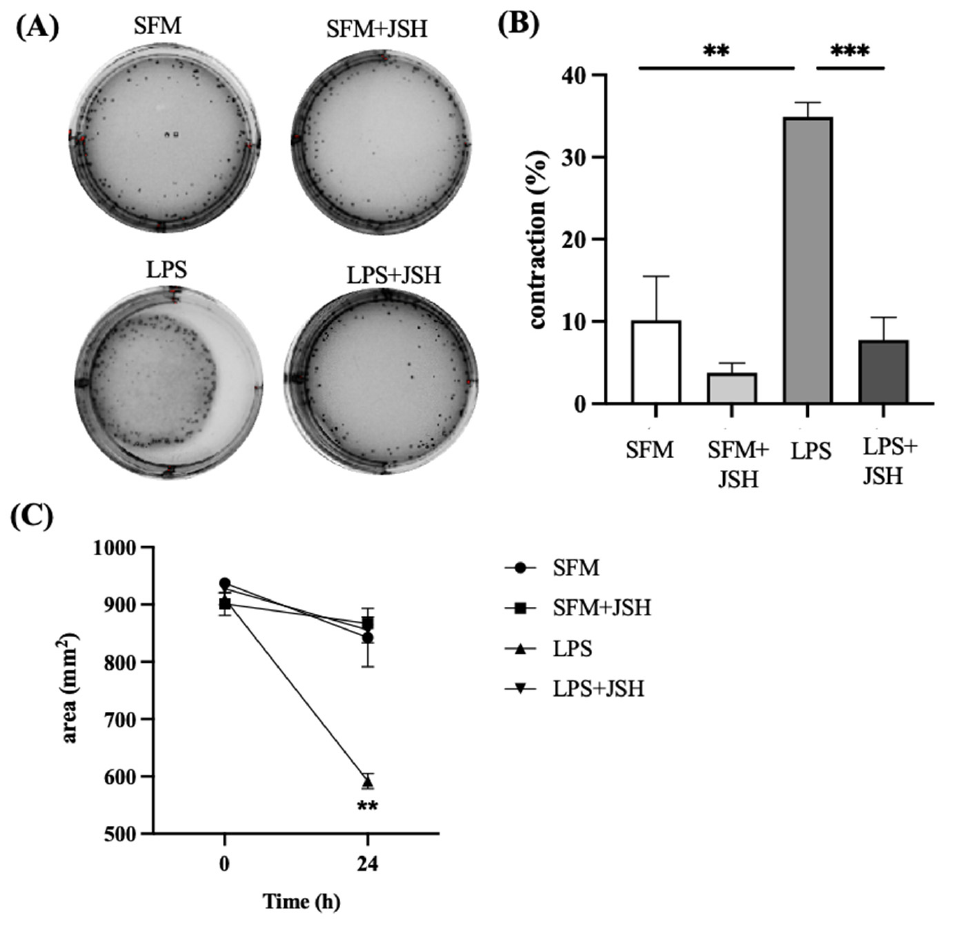
Figure 6. Effect of the NF- κ B inhibitor JSH on LPS-induces myocyte–collagen gel contraction. ( A ) Photographs of collagen lattices containing human myometrial cells, induced with LPS (100 ng/mL) or vehicle (SFM) with/out JSH (20 µ M). ( B ) Bar graphs represent the contraction of collagen lattices after 24 h of stimulation, compared to the basal surface area (percentage of gel area at time “0” versus “24 h”). ( C ) Shown are changes in collagen lattice area post LPS-stimulation with JSH treatments. Individual human myometrial cell lines ( n = 3) were used with n = 4 technical replicates for every experimental condition. Data are presented as mean ± SD. Statistical significance was determined by one-way ANOVA followed by Dunnette’s multiple comparisons test. ‘**’ denotes statistical significance at p < 0.01 and ‘***’ at p < 0.001.